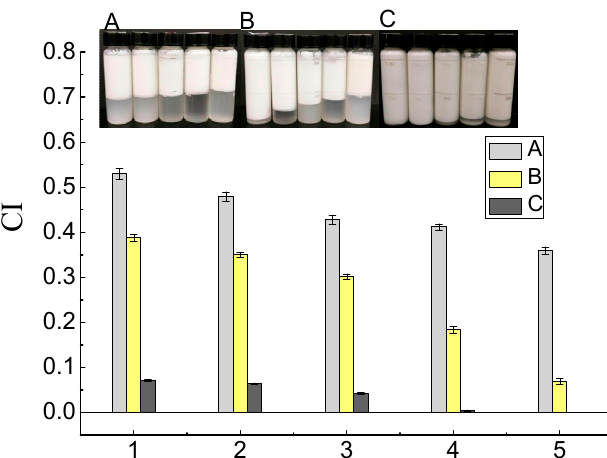
Figure 6. Creaming index (CI) of primary emulsions (1, 2, 3, 4, and 5 represent protein content of 0.8 g/100 g, 1.8 g/100 g, 2.8 g/100 g, 3.8 g/100 g, and 4.8 g/100 g, respectively); secondary emulsions (1, 2, 3, 4, and 5 represent protein content of 3.8 g/100 g; and SBP content was 0.01 g/100 g, 0.02 g/100 g, 0.05 g/100 g, 0.10 g/100 g, and 0.15 g/100 g); laccase-treated secondary emulsions (1, 2, 3, 4, and 5 represent protein content of 3.8 g/100 g, SBP content of 0.10 g/100 g, and laccase content of 2 U/100 g, 4 U/100 g, 6 U/100 g, 8 U/100 g, and 10 U/100 g).